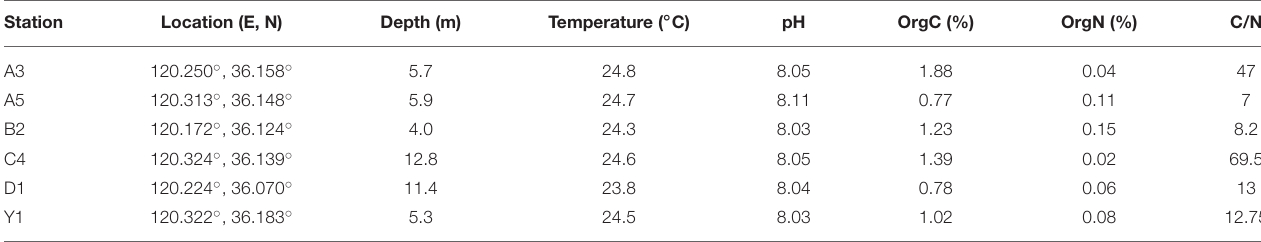
TABLE 1 | Characteristics of the sampling stations.